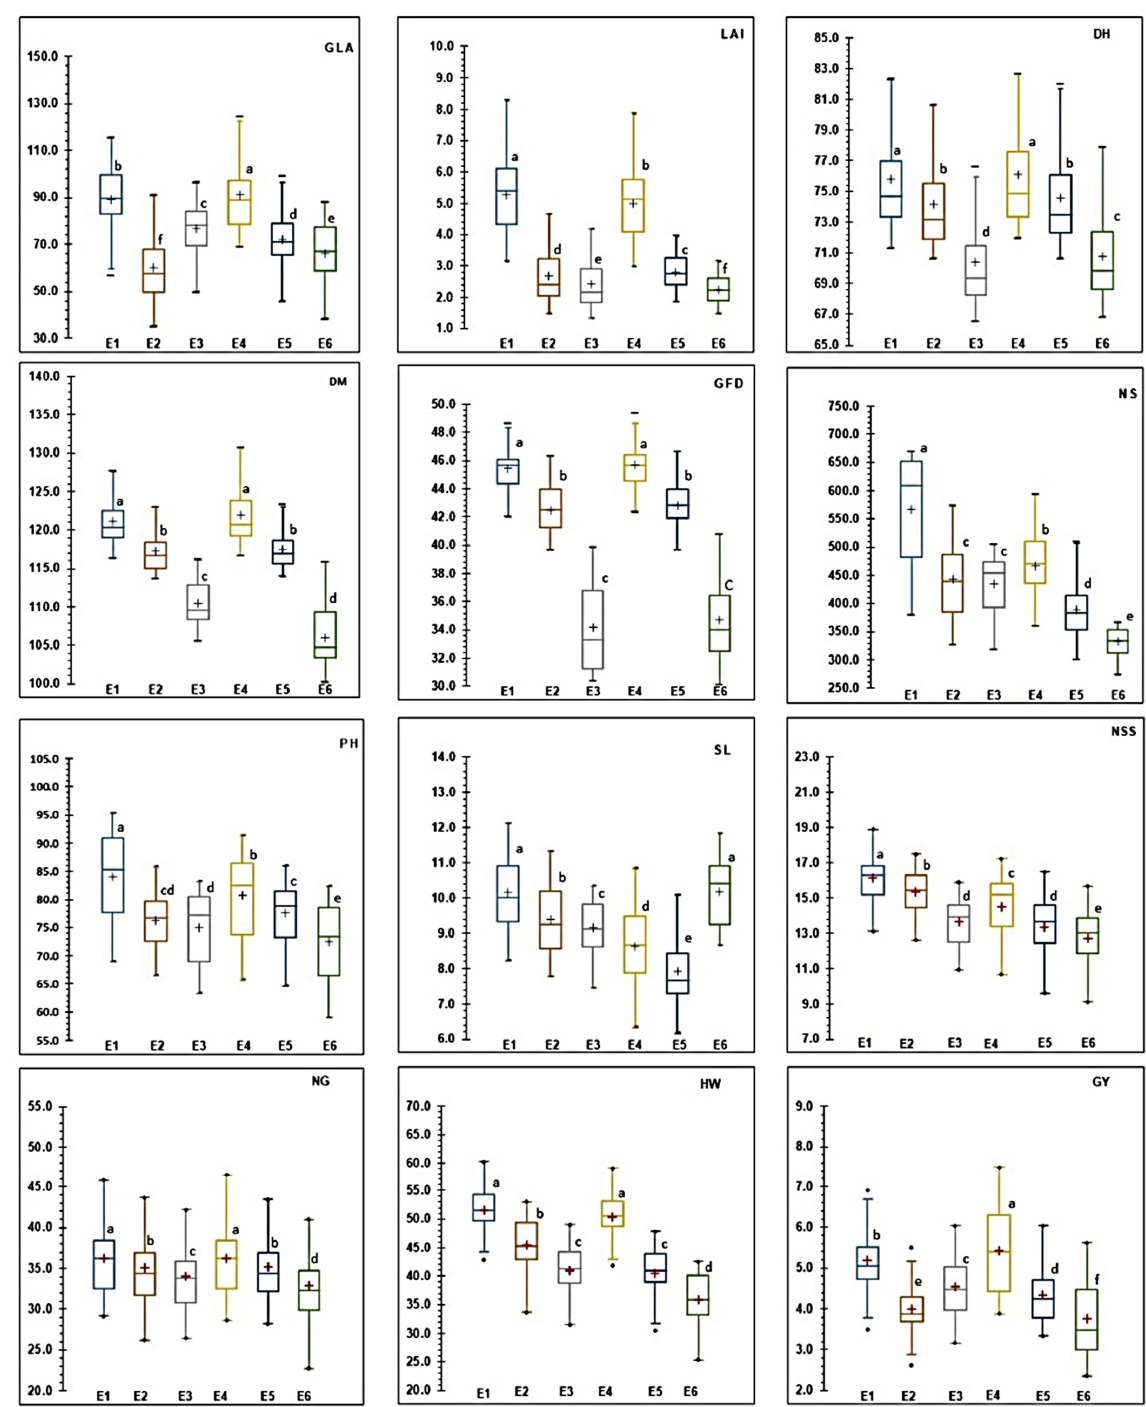
Figure 2. Boxplots illustrating the descriptive statistics of 12 measured traits in six environments of 20 genotypes wheat. The plus signs are treatment means, and the horizontal lines dividing the box represent the first quartile (25th percentile), medians and third quartile (75th percentile). The lower and higher whiskers reflect the minimum and maximum values, respectively. The letters denote significant variation between the six environments at 0.01% levels of probability. Units of traits are as follows: and green leaf area (GLA), leaf area index (LAI), days to heading (DH), days to maturity (DM), grain filling duration (GFD), plant height (PH), spike length (SL), number of spikes (NS), number of spikelets (NSS), number of kernels (NKS), thousand-kernel weight (TKW), and grain yield